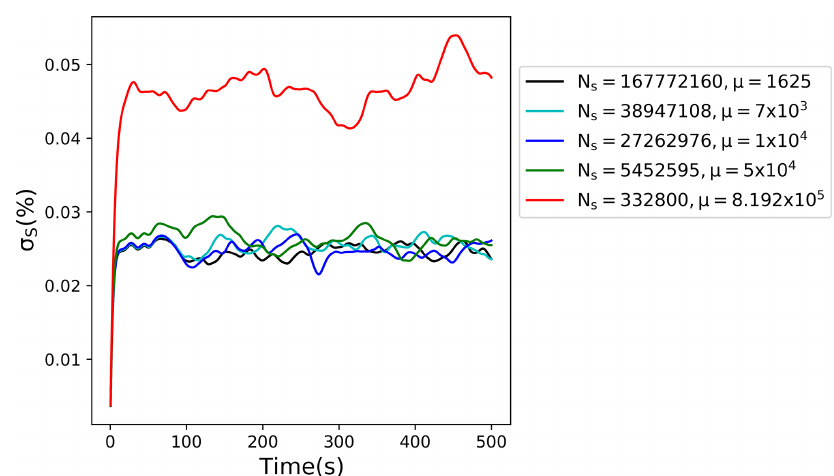
Figure 8. Standard deviation of supersaturation fluctuations for the 12 . 8 3 m 3 scaled-up domain. Colors indicate different multiplicities.